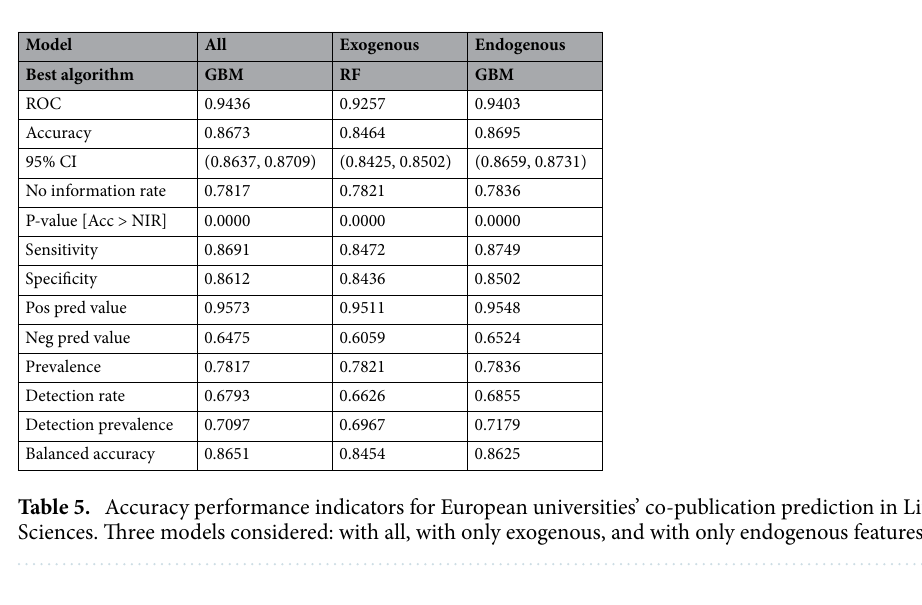
Figure 5. Precision–recall curves for European universities’ co-publication prediction in the Life Sciences. Three models considered: with all, with only exogenous, and with only endogenous features.